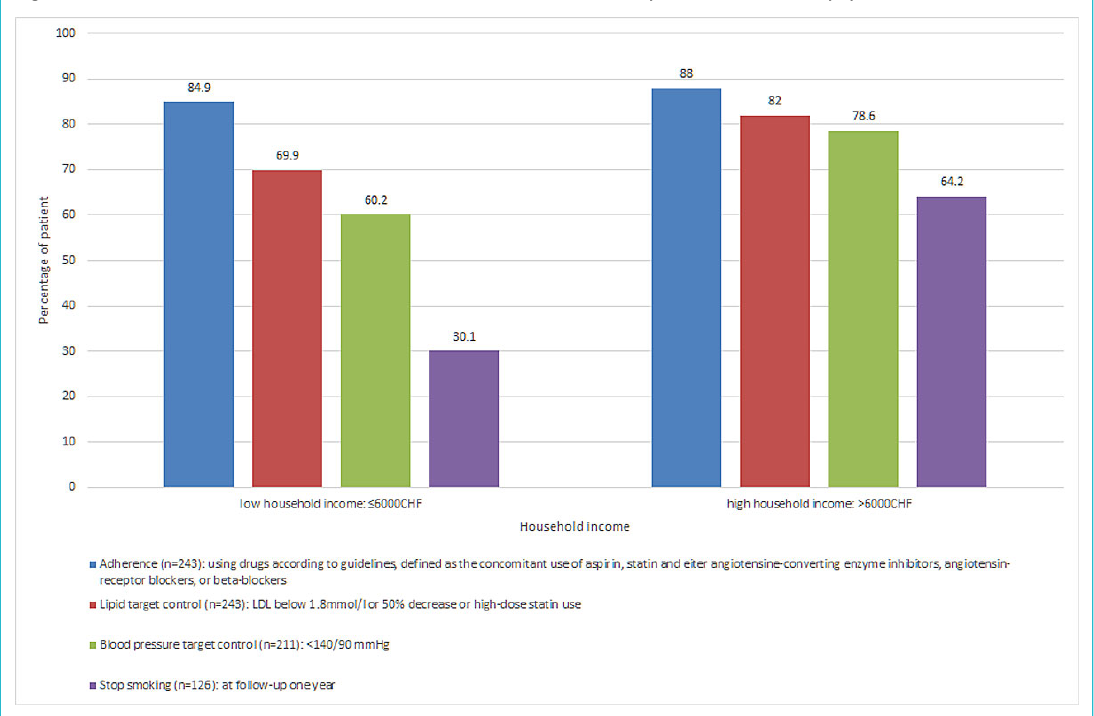
Figure 1: Association between income and control of cardiovascular risk factors one year after acute coronary syndrome.